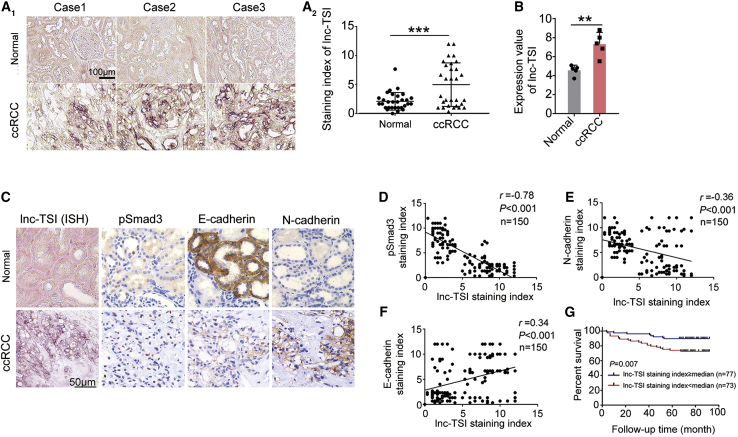
Expression of Tumor lnc-TSI Was Associated with Survival Rate in Patients with ccRCC(A) Representative images (A1) of in situ hybridization and the data analysis results (n = 30, A2) showed that lnc-TSI was upregulated in human ccRCC tissues. (B) lnc-TSI was upregulated in human ccRCC tissues from GEO: GSE96574, including five-pair ccRCC tissues and adjacent normal tissues. (C) Representative images for in situ hybridization of lnc-TSI and immunohistochemistry assays for pSmad3, E-cadherin, and N-cadherin in tumor tissue and the adjacent normal tissue. (D–F) The Spearman’s rank correlation analysis showed associations of the lnc-TSI staining index with the pSmad3 staining index (D), N-cadherin staining index (E), and E-cadherin staining index (F) in ccRCC tissues from 150 patients with ccRCC. (G) Kaplan-Meier survival analysis showed that patients with higher expression of lnc-TSI (greater than or equal to the median) at the time of radical nephrectomy (n = 77) had a higher rate of survival during a 30.9-month mean follow-up, compared to those with lower lnc-TSI expression (below the median, n = 73). ∗∗p < 0.01, ∗∗∗p < 0.001.